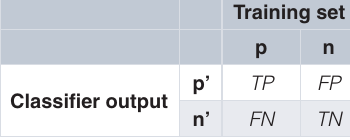
Table 1. Confusion matrix for training of a binary classifier. TP: Number of true positives. FP: Number of false positives. FN: Number of false negatives. TN: Number of true negatives.